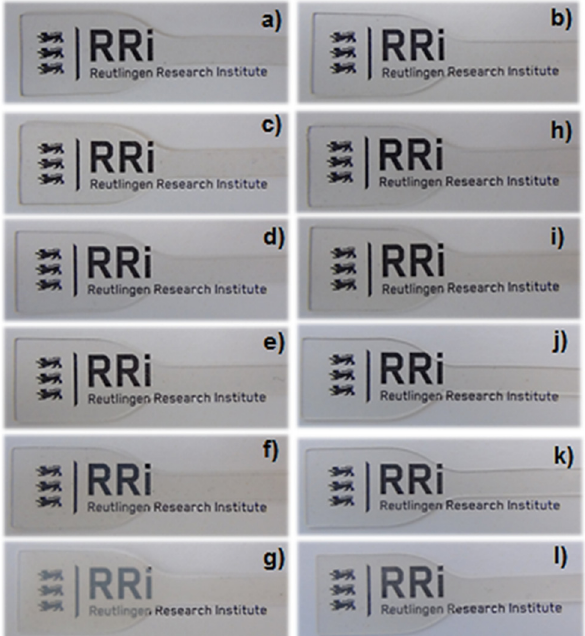
Figure A5. Photographs of PDMS-based PUr elastomer samples used for tensile testing. ( a ) PSU MDI-1.5%. ( b ) PSU CHDI-1.0%. ( c – g ) PSU H 12 MDI series with HS contents: ( c ) 1.6%, ( d ) 5%, ( e )